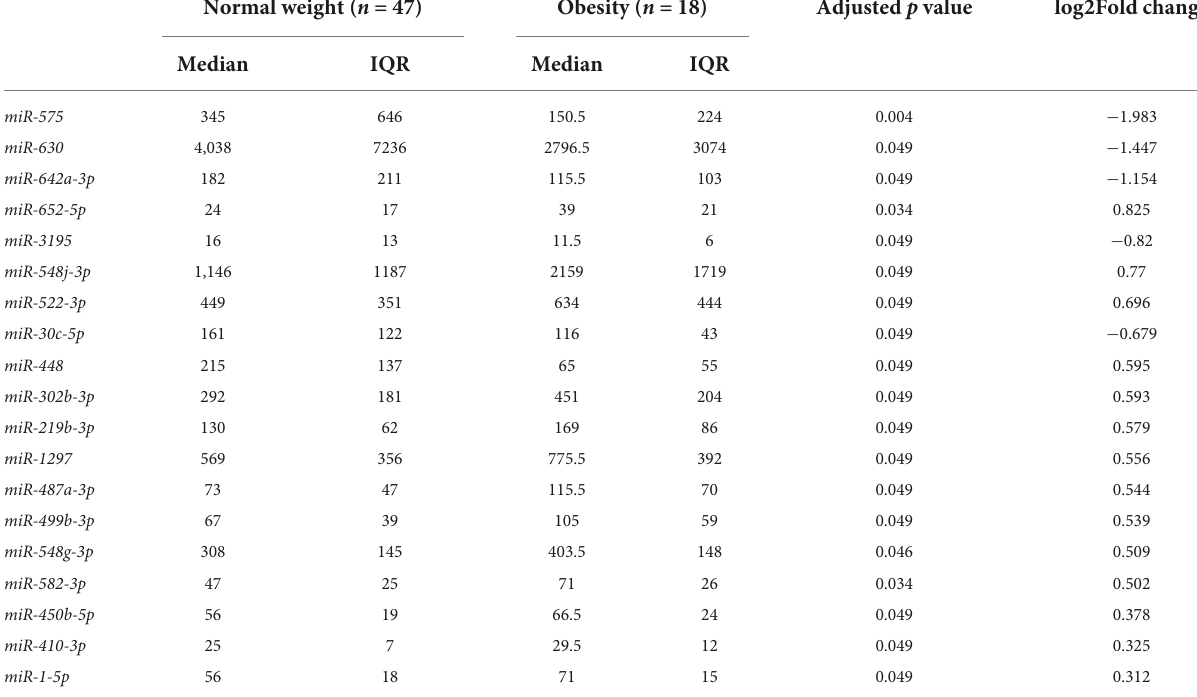
TABLE 2 Differentially expressed miRNAs in breast milk EVs of mothers with obesity (pre-pregnancy BMI ≥ 30) compared to mothers with normal weight (pre-pregnancy BMI < 25). Normal weight ( n = 47) Obesity ( n = 18) Adjusted p